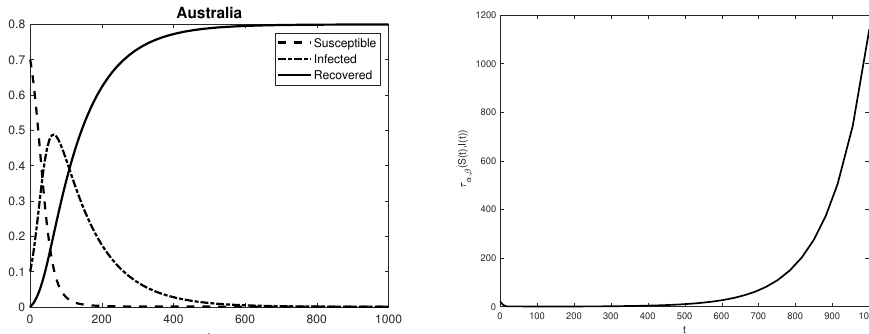
Figure 1. Solution to the SIR model (1), with initial value given by the vector (4), for Australia ( left ) and corresponding pattern of τ α , β ( S ( t ) , I ( t )) ( right ).